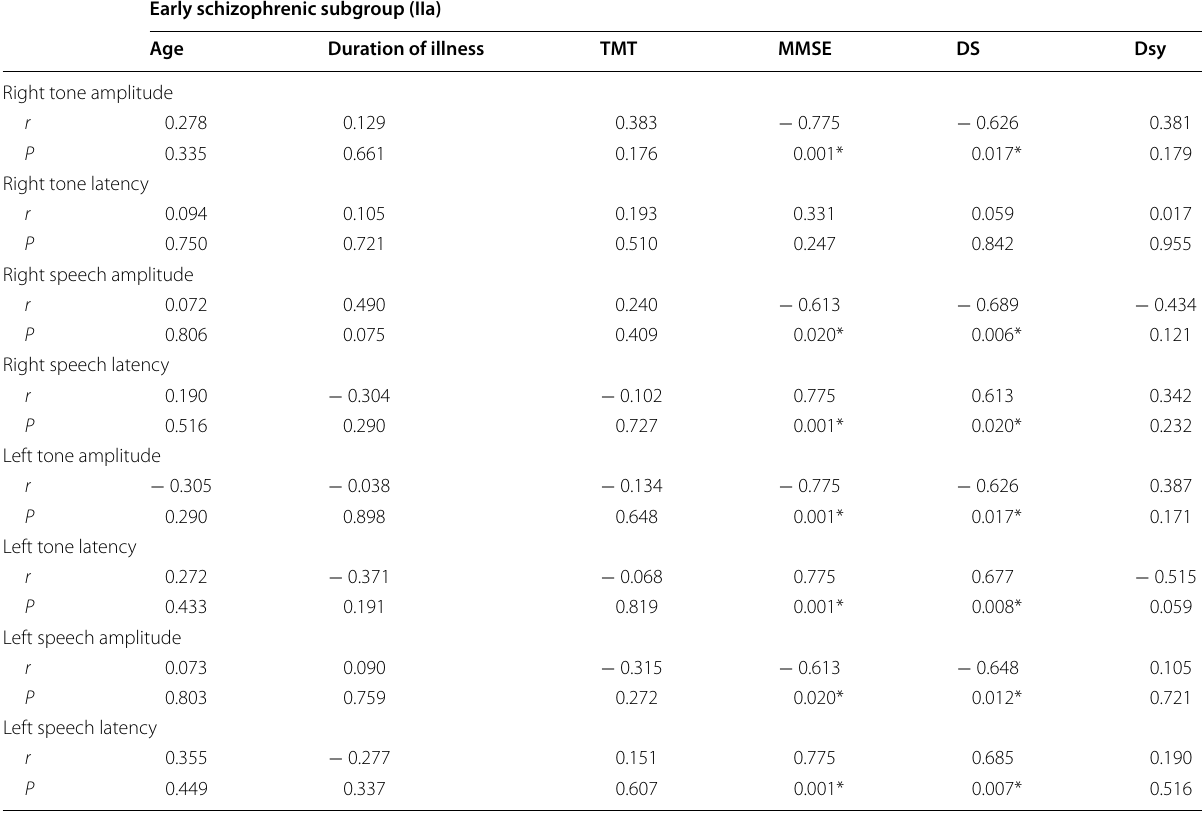
Table 3 Correlations between MMN parameters and each of the age, duration of illness and the studied psychometric scales in the right and left ears among early